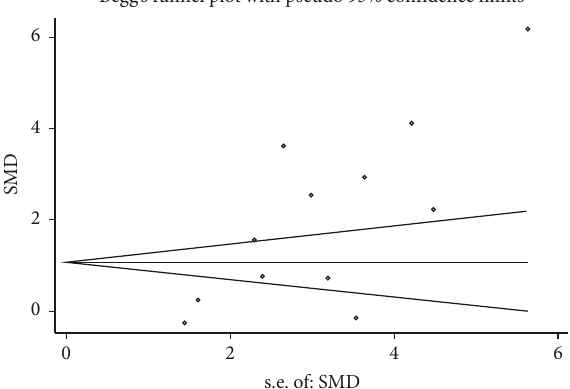
Figure 6: Publication bias via Begg’s test based on works of the literature providing the serum leptin concentration (continuity- corrected: z � 2.13, p � 0 . 034).